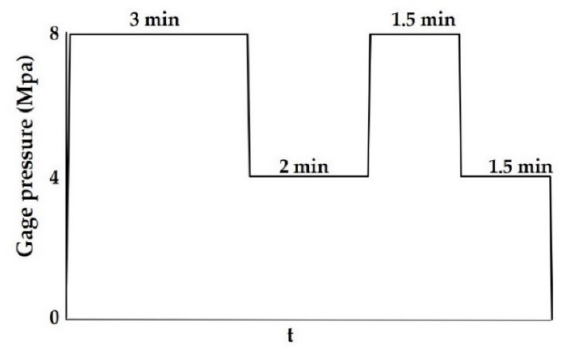
Figure 1. Pre-programmed schedule for hot-pressing process.